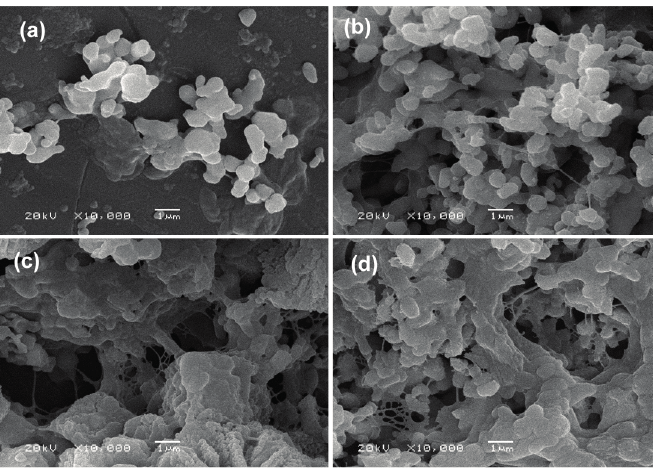
Figure 7. SEM morphology of MG-63 cells on the scaffolds for 7 days. ( a ) β -TCP; ( b ) β -TCP/SiO 2 ; ( c ) β -TCP/MgO; and ( d ) β -TCP/SiO 2